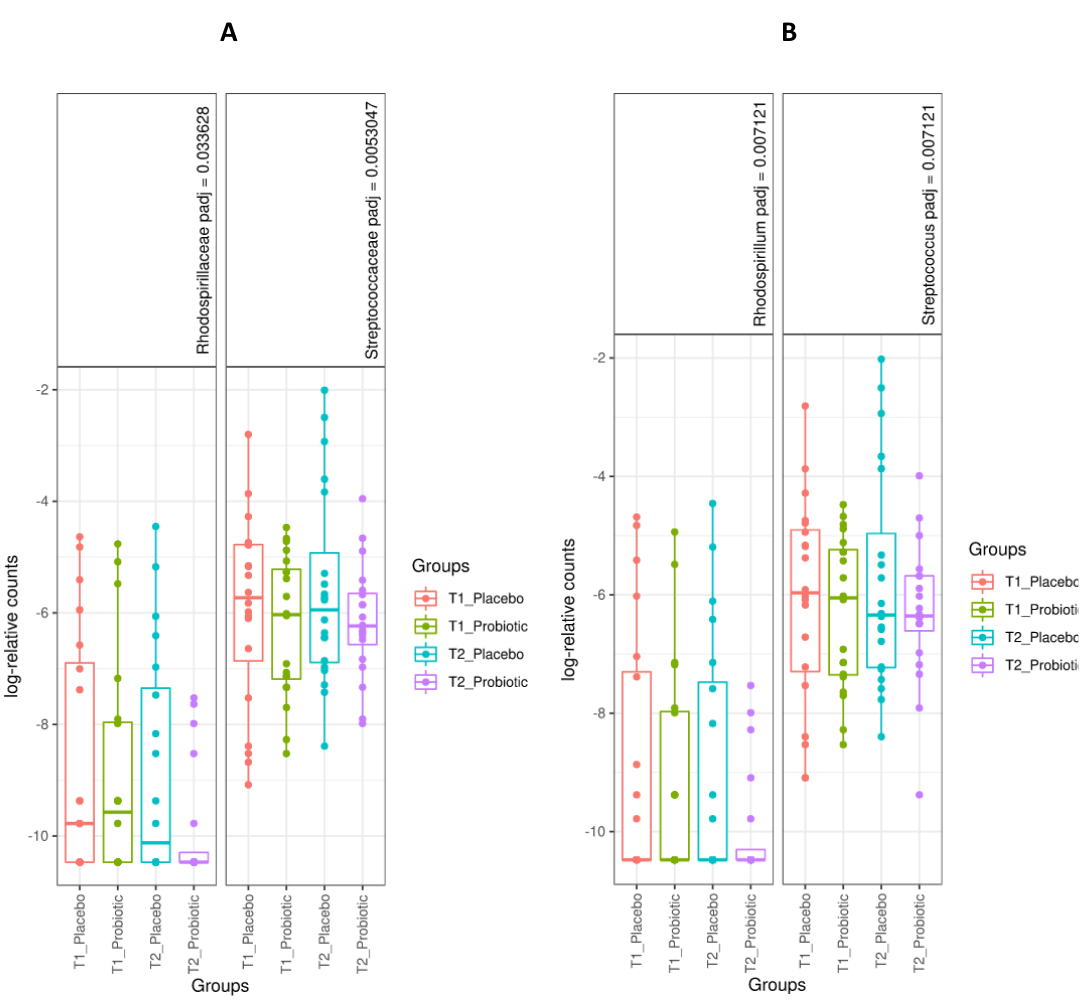
Figure 4. Differences between the placebo and probiotic groups at the end of the study (6 weeks) at the level of families ( A ) and genera ( B ).